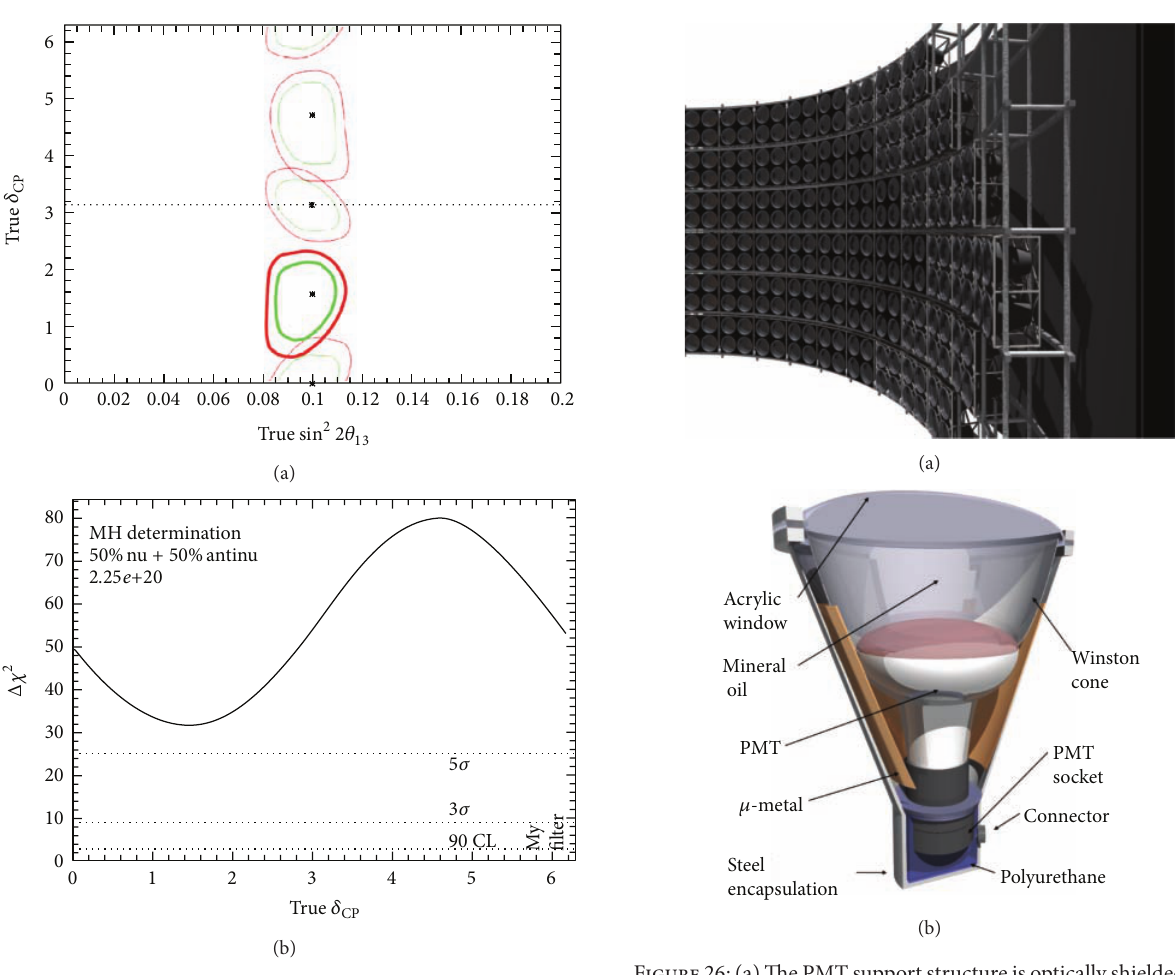
Figure 25: (a) The 68% and 90% CL contours in the 𝛿 plane. (b) Mass hierarchy determination at 5𝜎 [61].